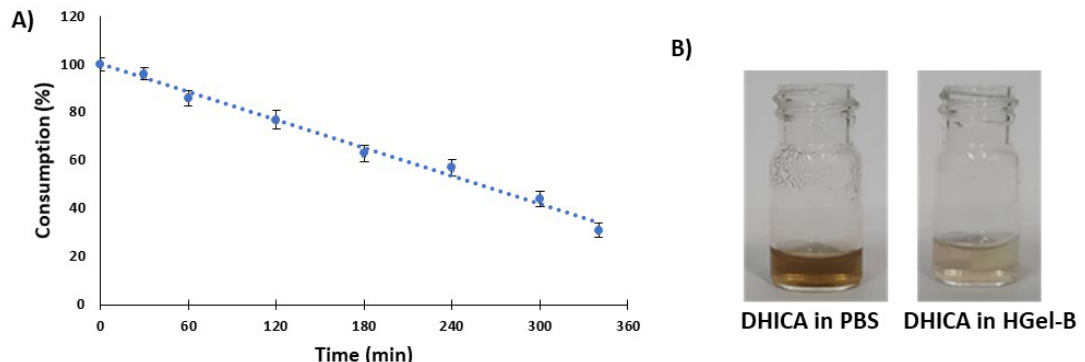
Figure 9. Panel A : Decay of free DHICA in the PBS solution monitored by HPLC analysis. Panel B : Appearance of the free DHICA solution in PBS (left) vs. the 10% w / w DHICA / HGel-B containing medium (right) over 6 h. Reported are the mean ± SD values of three experiments.